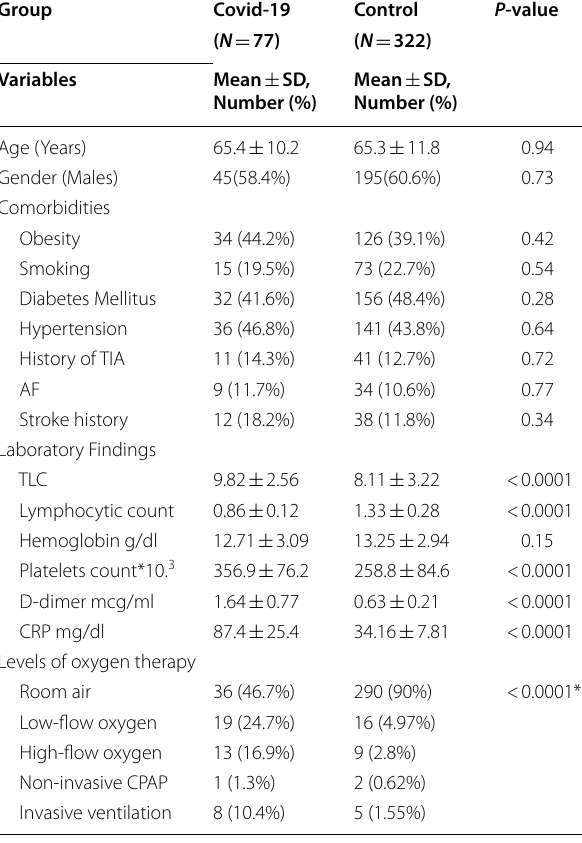
Table 1 Comparison between case and control groups regarding baseline factors